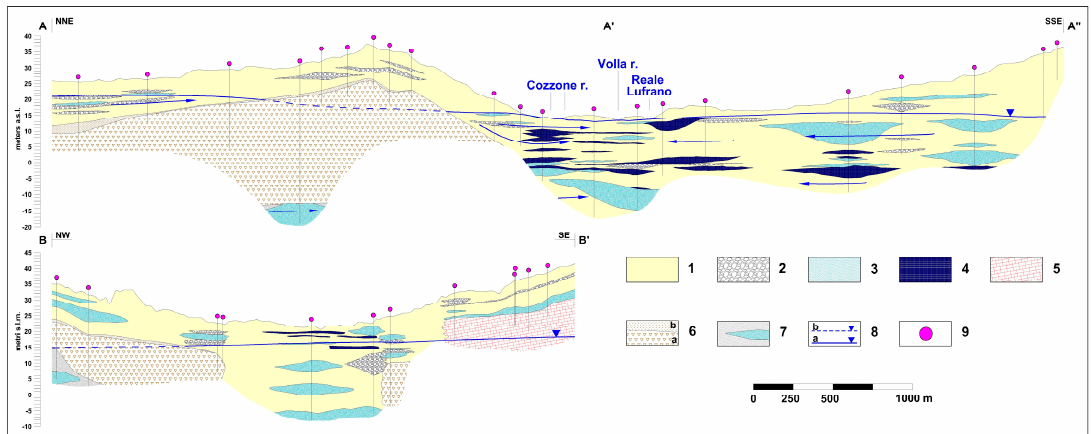
Figure 2. Hydrogeological cross-sections of the aquifer system. Legend: (1) silty sands; (2) pumiceous lapilli horizons; (3) sands; (4) marshy clay-sand and clay-silt levels; (5) incoherent or semi-lithoid lavas; (6) lithoid (a) and incoherent (b) CI tuff; (7) lapilli and coarse sands deposits; (8) phreatic (a) and semi-confined (b) piezometric level; and (9) borehole.